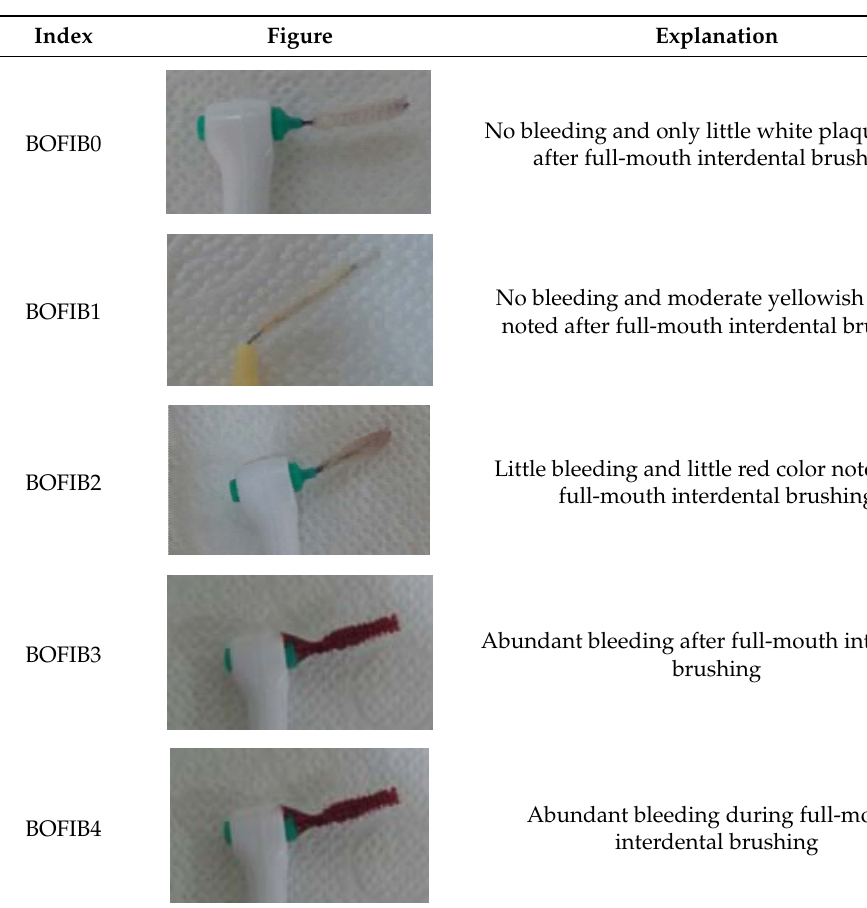
Table 2 . Bleeding on the full-mouth interdental brush (BOFIB) index.